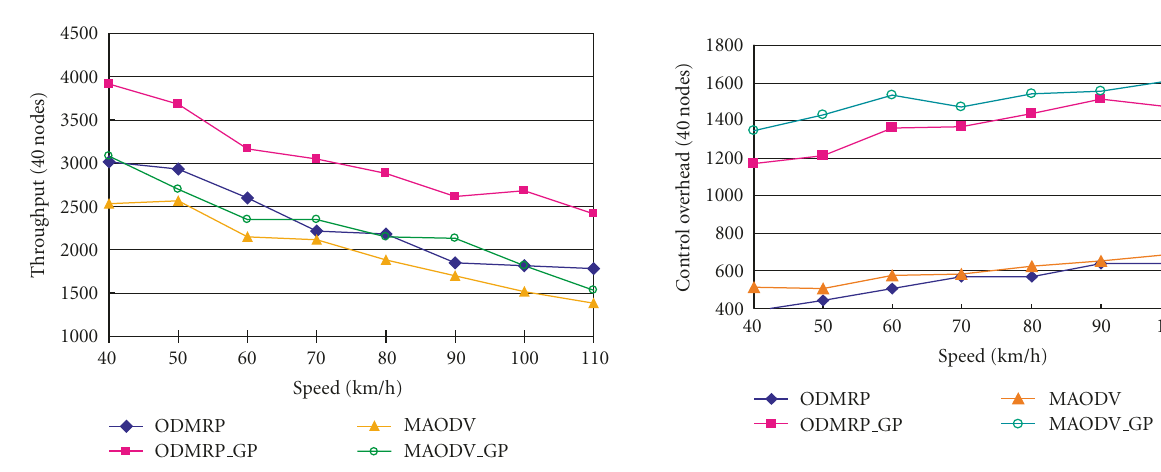
Figure 18: Control overhead versus mobility speed (40